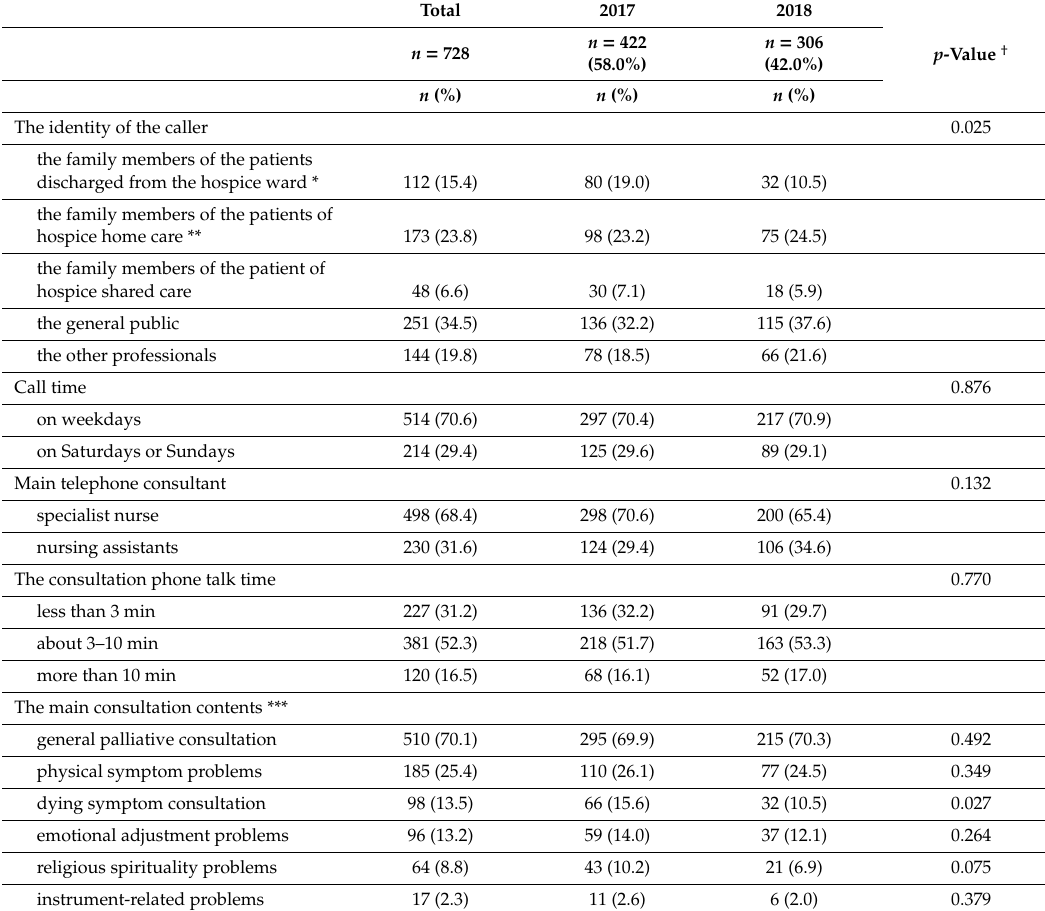
Table 2. Comparison of phone call data and phone call time of 24-hour specialist palliative care telephone advice service by